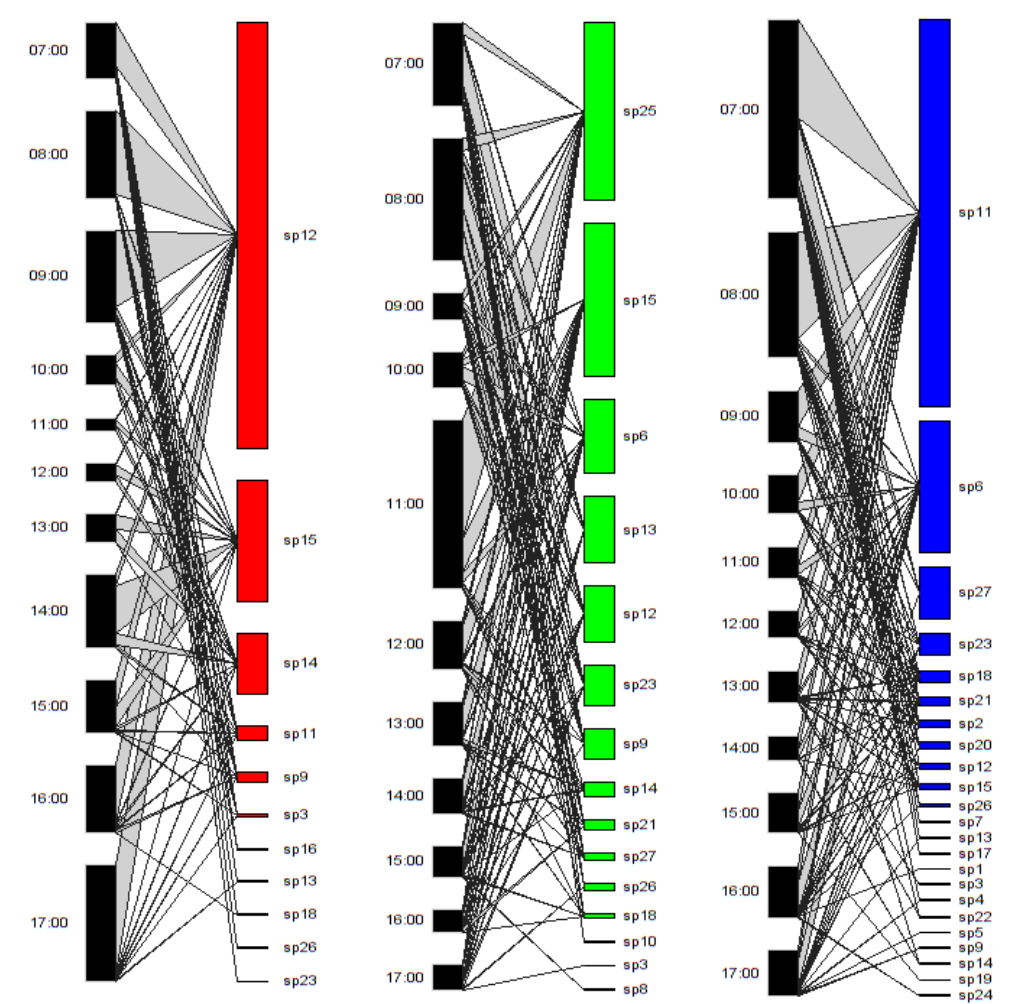
Fig 4. Temporal networks of foraging activity of ground-dwelling ants in the evaluated environments. Black left boxes are the foraging times and and the color of the boxes on the right represent the phytophysiognomies: Grassland (red); Shrub Caatinga (green); Tree Caatinga (blue). The thickness of the lines between the boxes corresponds to the abundance of individuals. The code of species is: sp1: Azteca sp; sp2: Blepharidatta conops; sp3: Brachymyrmex admotus; sp4: Brachymyrmex heeri; sp5: Camponotus cameranoi; sp6: Camponotus crassus; sp7: Camponotus melanoticus; sp8: Cephalotes pusillus; sp9: Crematogaster victima; sp10: Dinoponera quadríceps; sp11: Dorymyrmex bicolor; sp12: Dorymyrmex brunneus; sp13: Ectatomma muticum; sp14: Forelius brasiliensis; sp15: Forelius maranhaoensis; sp16: Kalathomyrmex emeryi; sp17: Odontomachus bauri; sp18: Pheidole diligens; sp19: Pheidole fallax; sp20: Pheidole fimbriata; sp21: Pheidole meinerti; sp22: Pheidole obscurithorax; sp23: Pheidole radoszkowskii; sp24: Pseudomyrmex urbanus; sp25: Solenopsis substituta; sp26: Solenopsis globularia; sp27: Solenopsis